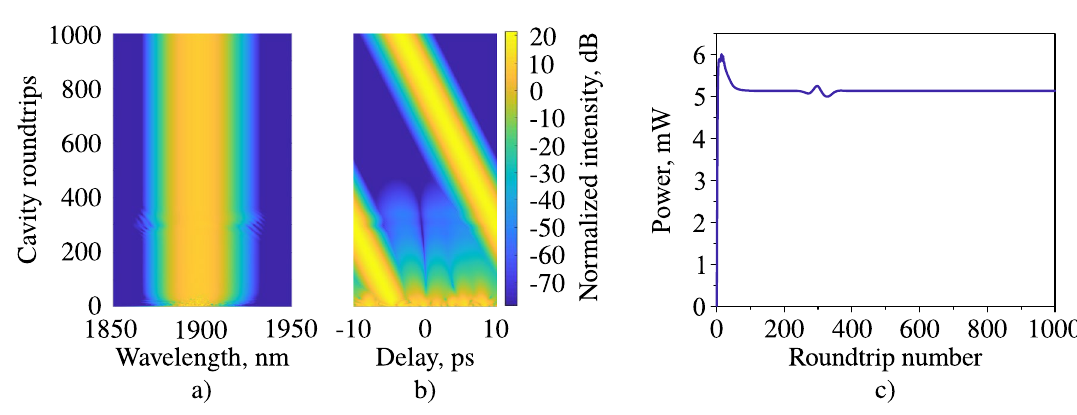
Figure 4. ( a ) Spectral, ( b ) temporal, ( c ) average power evolution on the roundtrip at the output